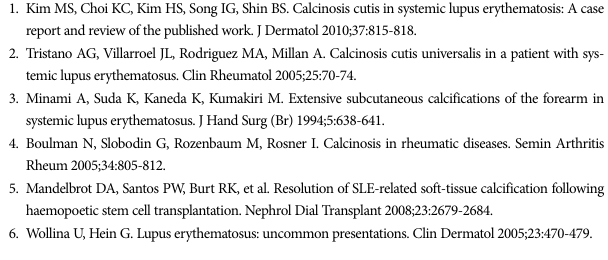
Fig. 4. Coronal CT scan of the proximal lower limbs demonstrate extensive calcifications in the subcutaneous tissue around both knees as well as both